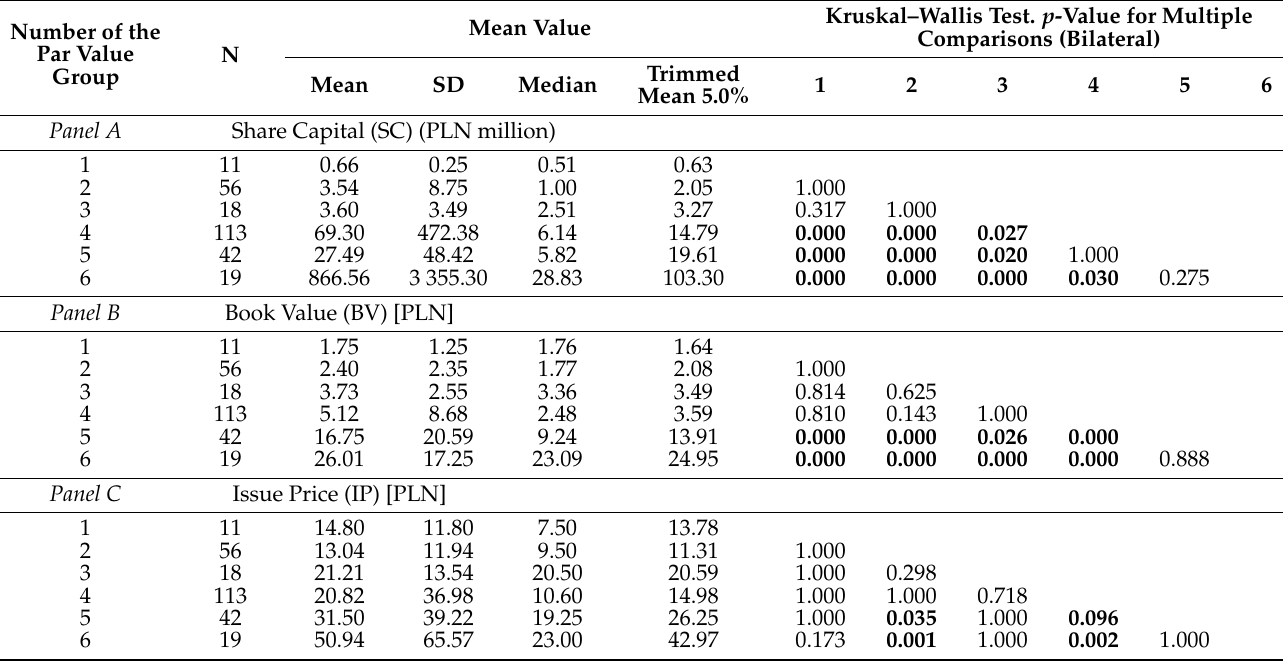
Table 6. Financing parameters of first-degree relationships depending on